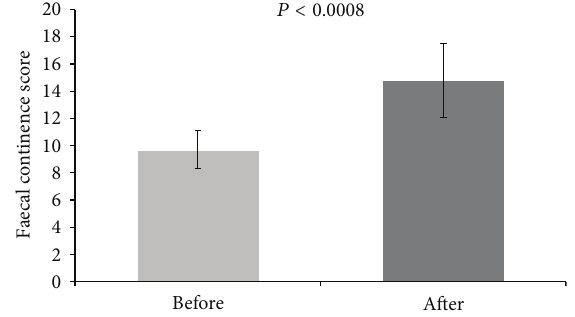
Figure 1: Faecal continence score before and after Peristeen D